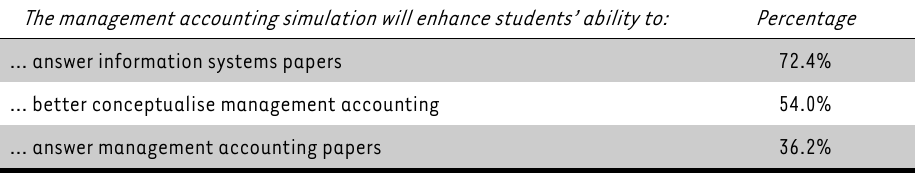
Contribution of the simulation to different areas of students’ studies The management accounting simulation will enhance students’ ability to: